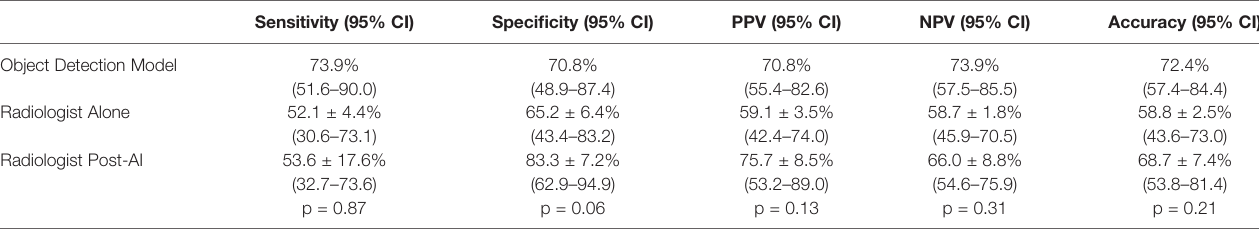
TABLE 4 | Sensitivity, speci fi city, PPV, and NPV, and accuracy from the AI alone, TI-RADS alone, and AI + TI-RADS.